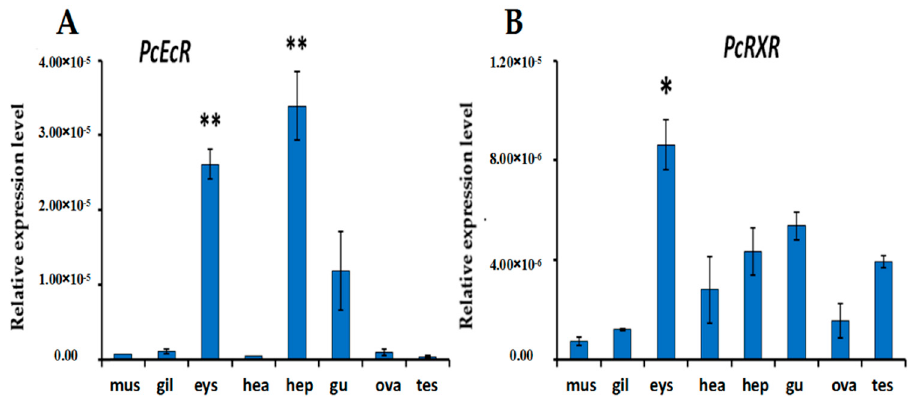
Figure 4. PCR analysis of relative expression levels of PcEcR ( A ) and PcRXR ( B ) in eight tissues of P. clarkii . mus: muscle; gil: gill; eys: eyestalk; hea: heart; hep: hepatopancreas; gu: gut; ova: ovary; tes: testis; Each data point represents the mean and standard deviation ( n = 3 samples). The expression level in hepatopancreas was considerably higher than in other tissues (**: p < 0.01, *: p < 0.05; with Student’s t -test).